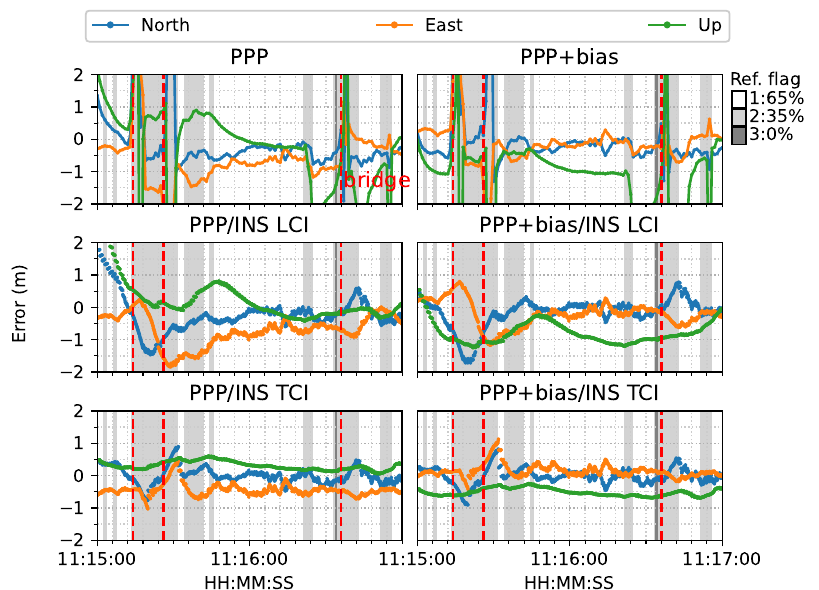
Figure 19. Re-convergence example 2. The red epochs 11:15:14 and 11:15:26 signify that the van was under a